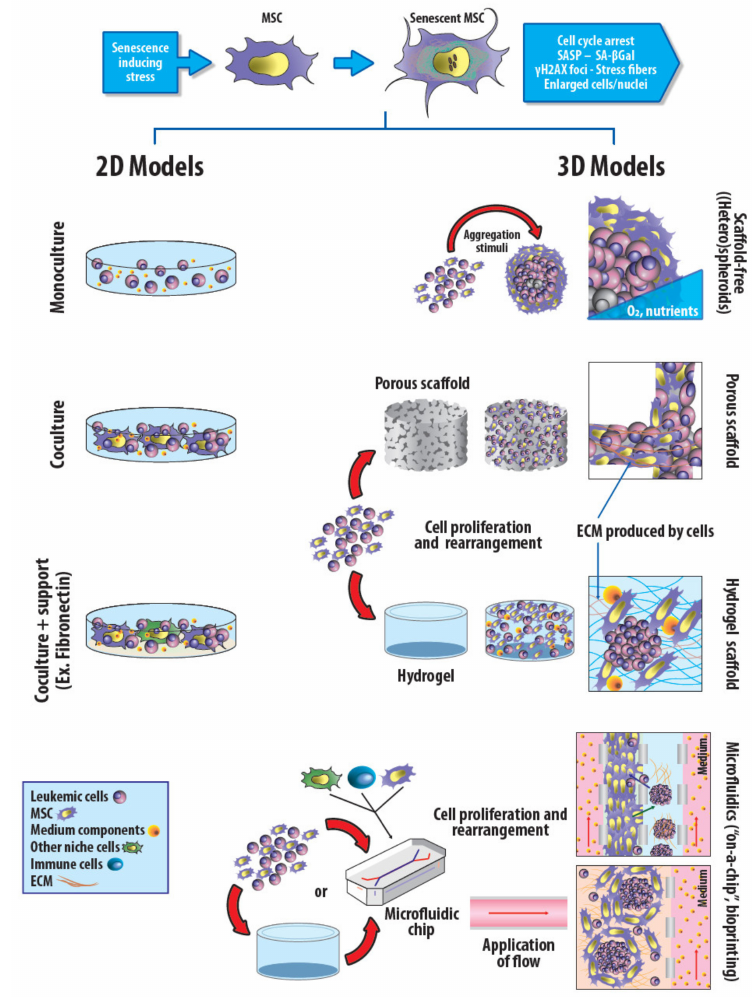
Figure 1. Common 2D and 3D in vitro culture models for cancer research. The use of young or senescent MSC as a support in 2D or 3D cultures for studying BM niche biology could exert differential effects on leukemic cell biology. In 2D cultures, cells grow as a suspension or as a monolayer on a flat plastic surface that can be coated or not with matrix components (fibronectin, collagen, vitronectinetc.); these kinds of systems may include one, two or more types of cells. On the other hand, 3D cultures have been developed to improve the representation of architectural, multicomponent complexity of the biochemical interactions in cancer and BM biology. Probably, the simplest way to obtain a 3D conformation is to induce the formation of spheroids composed by one or more cellular types; this can be accomplished by spontaneous formation on low-attachment surfaces, magnetic levitation, spinner flasks, among others. The use of different types of scaffolds provides a support for cell adhesion, proliferation, differentiation and migration. The scaffolds can be built with biomaterials, such as decellularized native tissues, ceramic (hydroxyapatite, bioglass), natural (collagen, fibrin, alginate, chitosan) or synthetic polymers (polyethylene glycol, polycaprolactone, poly(hydroxyethylmethacrylate), poly(lactic-co-glycolic acid)). Among the most frequently used polymers, hydrogels are preferred for their similarities to ECM mechanical properties. The application of 3D bioprinting techniques (not depicted) and the development of microchips compatible to single- cell methodologies have allowed the engineering of devices where a flow can be applied to improve cell proliferation/migration, add immune cells or test compounds in situ in a way that maintains microenvironments physically and biochemically differentiated but allow communication among them. Depending on the microchip device design and the inclusion or not of scaffolds, different culture models can be obtained. Based on [65–67] {Borghesan, 2020 #585; Cucchi, 2020 #586; Rodrigues, 2021